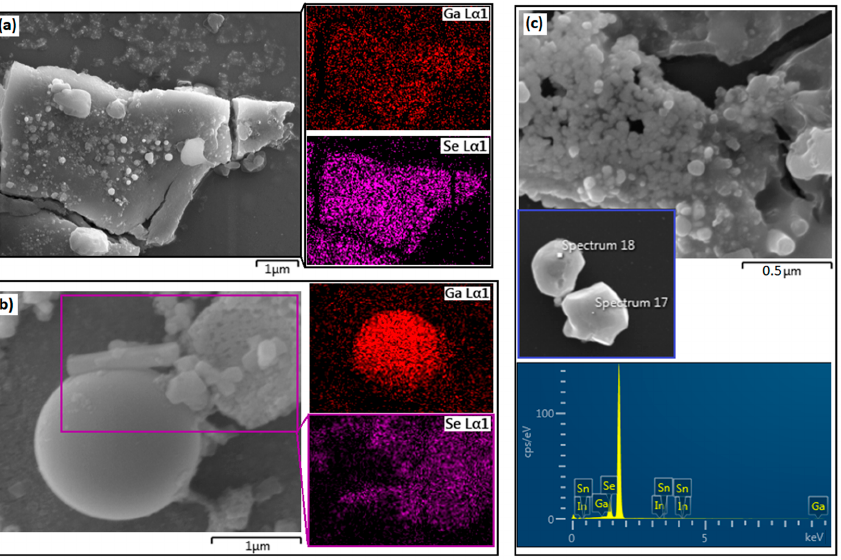
Figure 2. ( a ) The SEM image accompanied by EDS analysis maps of Ga-Se nanosheet. ( b ) The SEM image showing the growth of Se-rich nanostructures on the surface of galinstan NPs accompanied by the EDS maps of nanostructures. ( c ) The Se nanoparticles grown individually during sonochemical reactions on the surface of galinstan NP. Table 1. The speci fi cations of various types of synthesized Se-rich nanostructures.